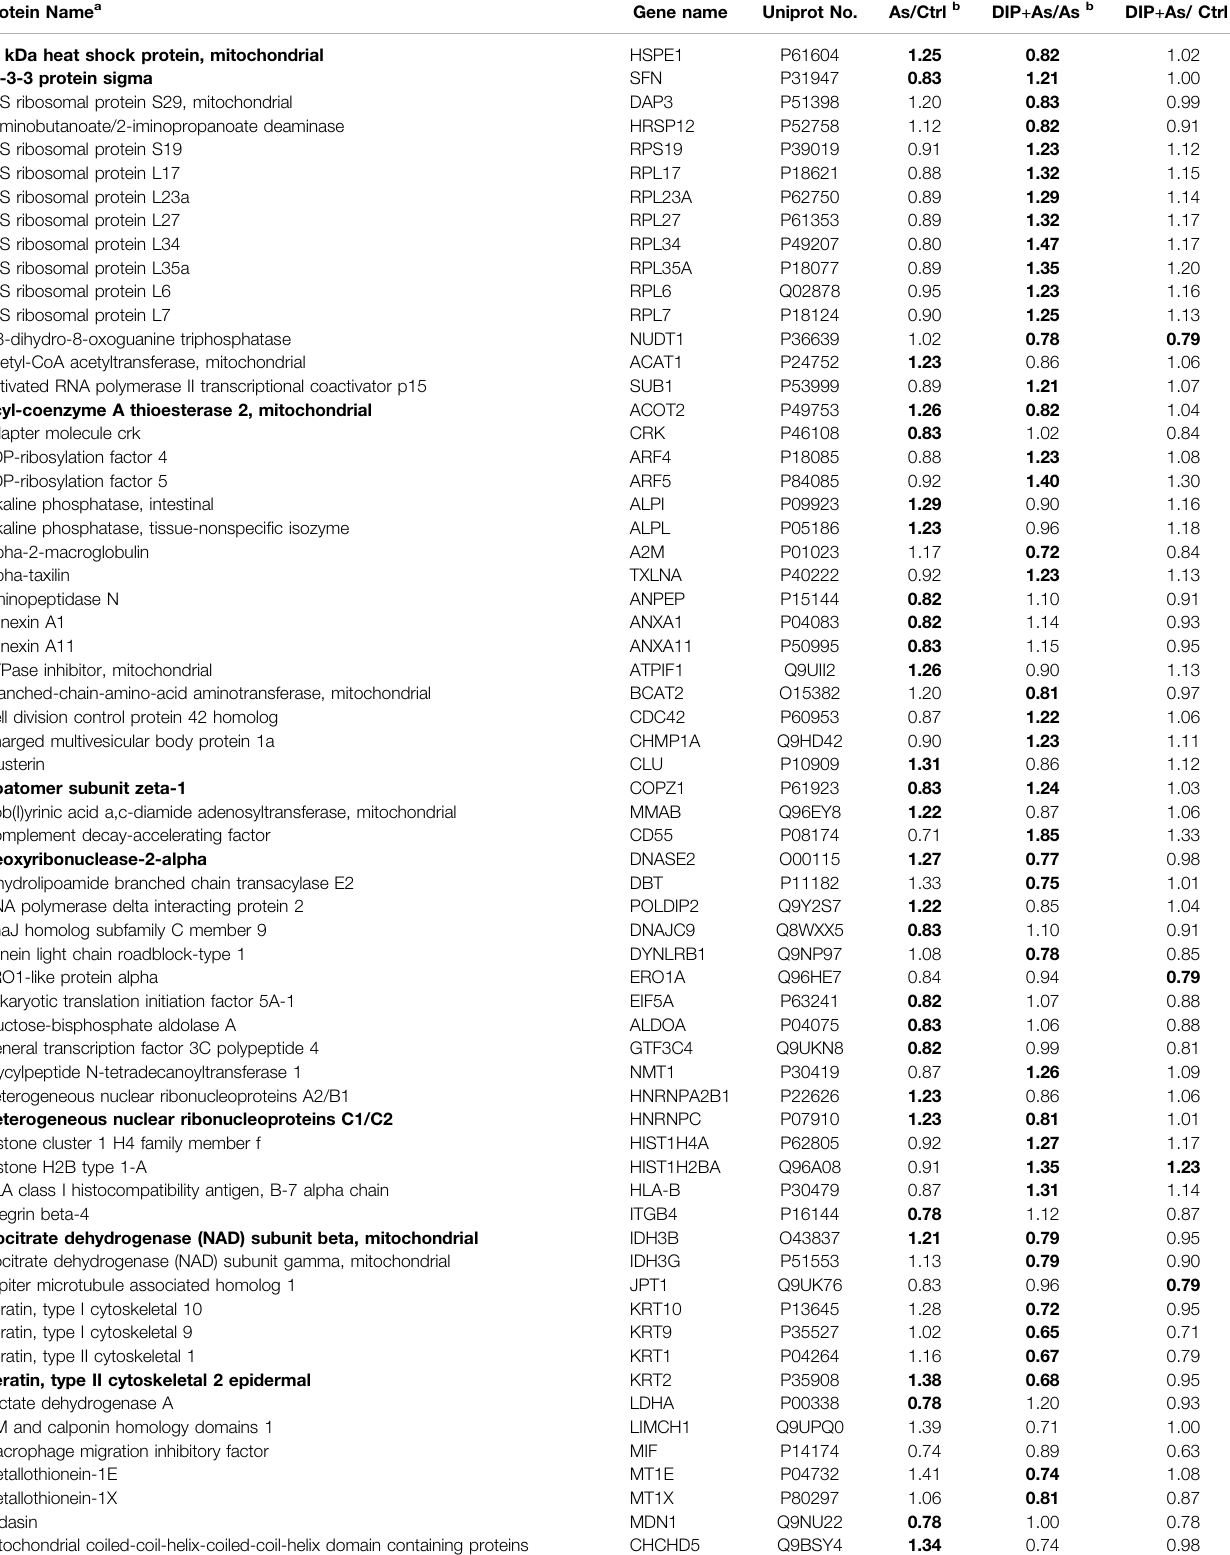
TABLE 1 | The differentially expressed proteins identi fi ed in different groups in this study. Protein Name